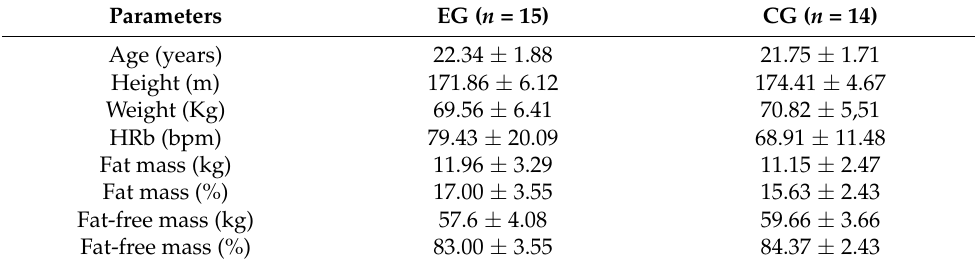
Table 1. Characteristics of the